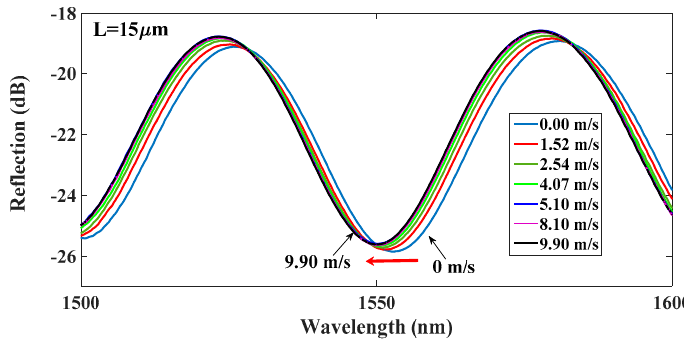
Figure 6. Reflection spectra of HPFFPI with L = 15 μ m for various speed of airflow.